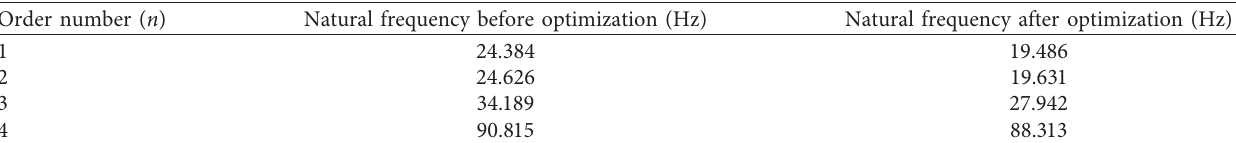
Table 2: Comparison of natural frequency of compression-shear test machine frame before and after optimization.